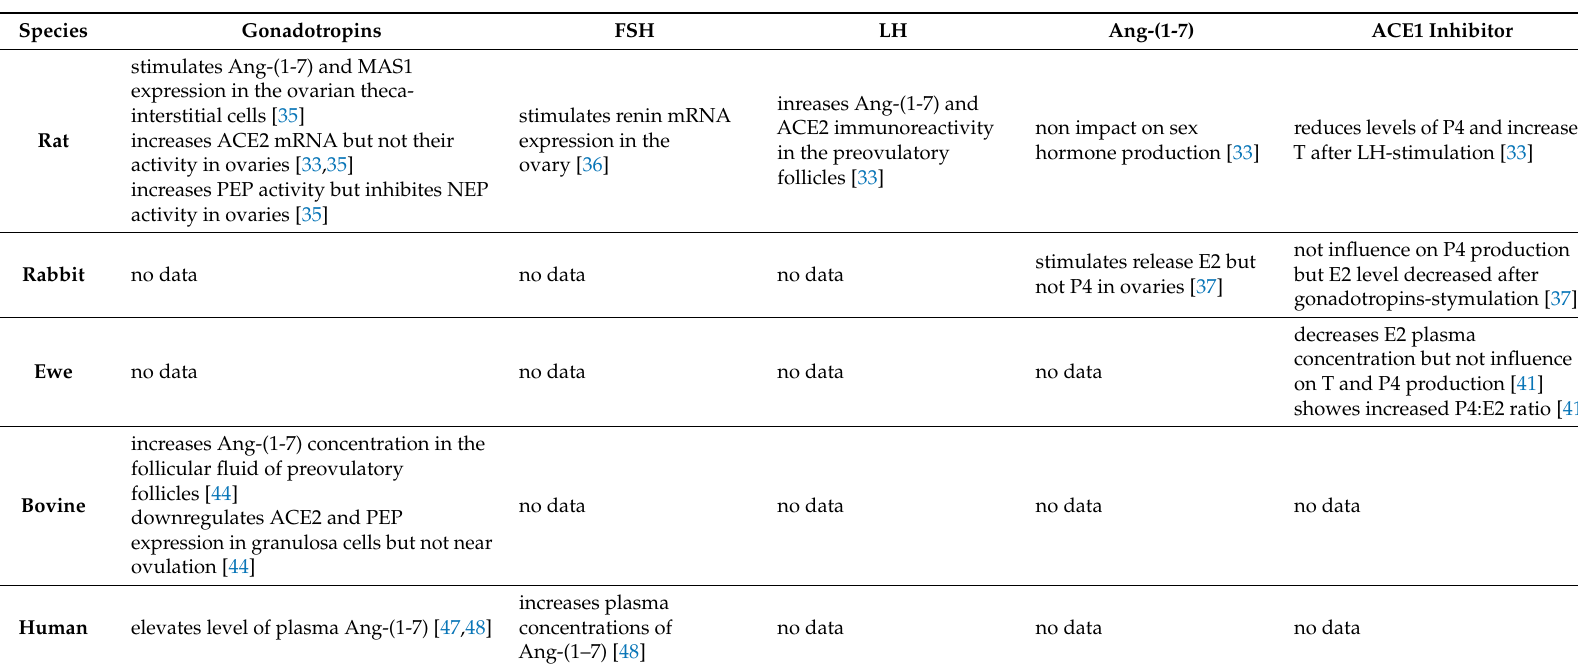
Table 2. Interaction between gonadotropins and sex hormones and ACE2 / Ang-(1-7) axis. (FSH— follicle-stimulating hormone; LH—luteinizing hormone; T—testosterone; E2—estradiol; P4—progesterone; ACE1—angiotensin-converting enzyme 1; Ang-(1-7)—angiotensin-(1-7); ACE2—angiotensin-converting enzyme